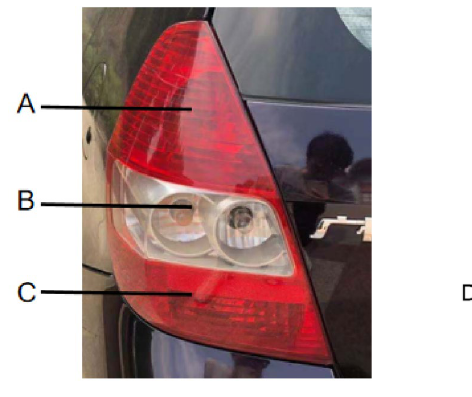
(a) Tail lamp area. (b) Tail lamp